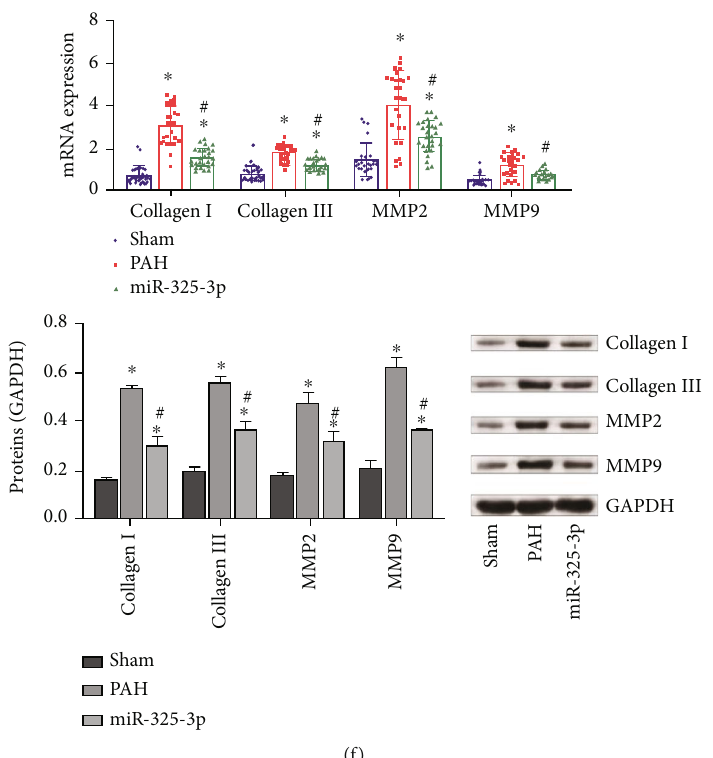
Figure 1: Overexpression of miR-325-3p alleviated myocardial fi brosis in rats with PAH. (a) HE staining of the pulmonary artery and quantitative statistics of pulmonary arterial medial wall thickness (%). (b) miR-325-3p expression in myocardial tissue was measured by qRT-PCR. (c) RVSP and RVHI of rats. (d) HE staining of the right ventricle ( × 100, 100 μ m). (e) Masson staining of the right ventricle ( × 100, 100 μ m). (f, g) qRT-PCR and Western blot were performed to measure collagen I, collagen III, MMP2, and MMP9 expressions in heart tissue. ∗ P < 0 : 05 vs. Sham; # P < 0 : 05 vs.